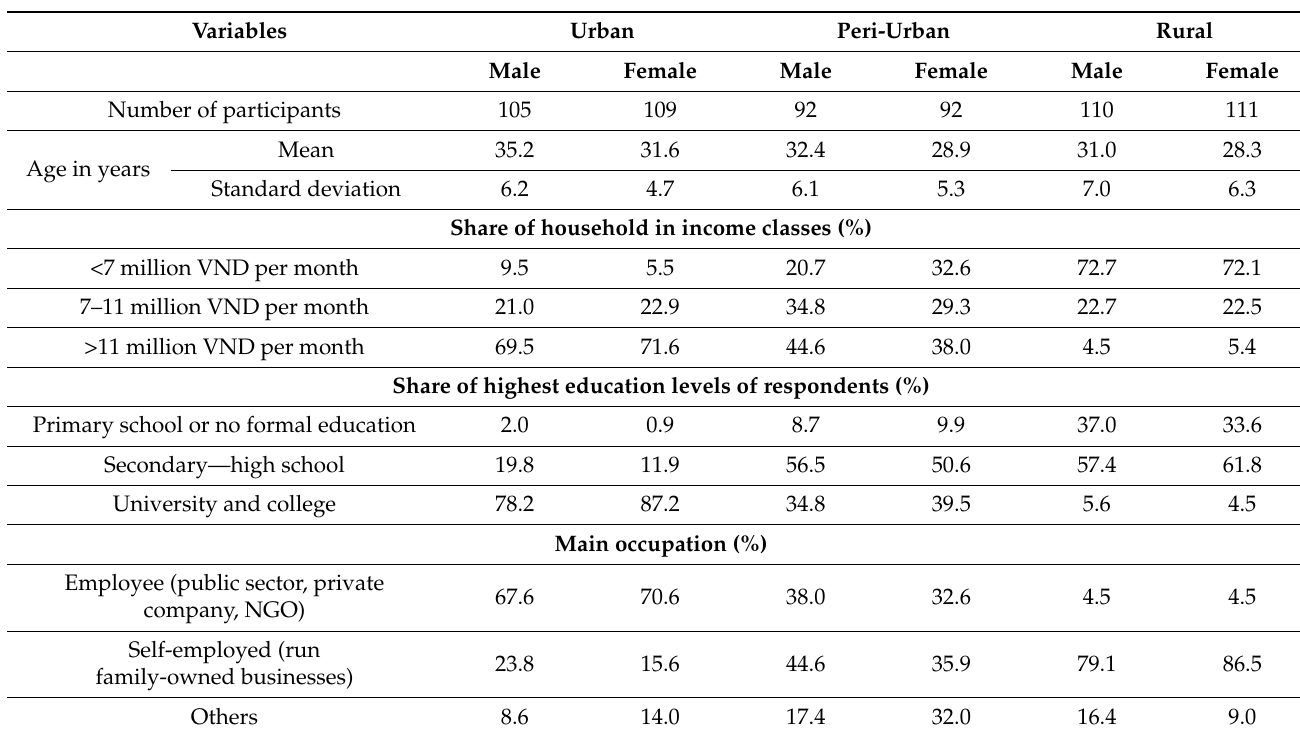
Table 1. Description of socio-demographic variables in the three